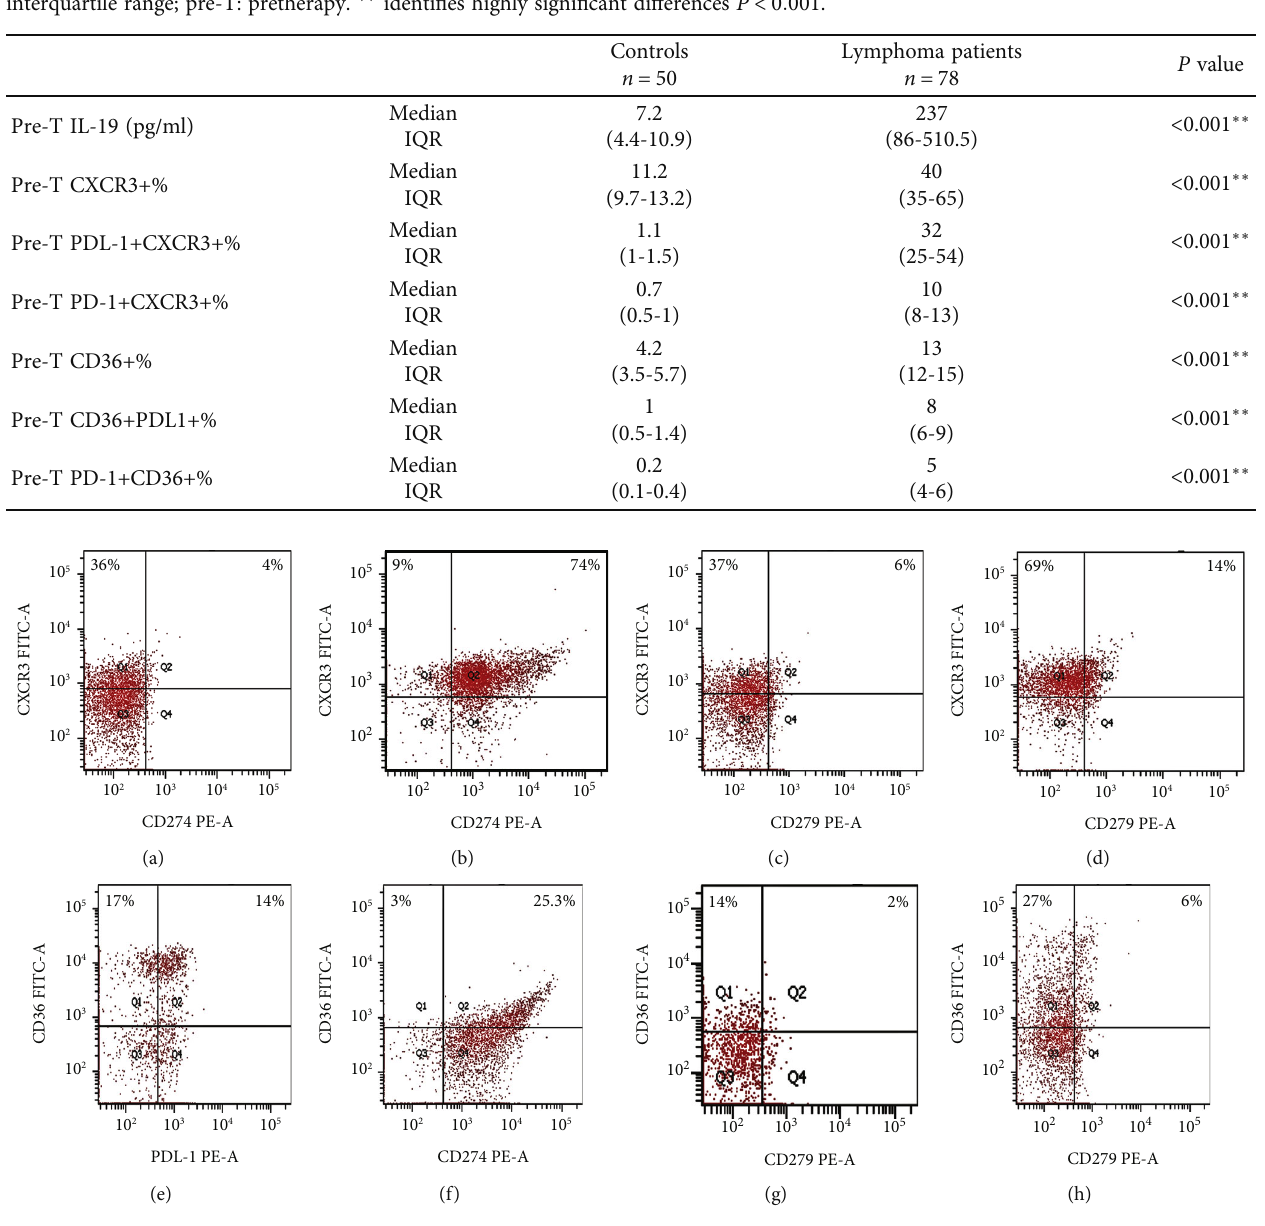
Table 2: IL-19 and PD-L1/PD-1 coexpression with CXCR3/CD36 in newly diagnosed lymphoma patients and healthy controls. IQR: